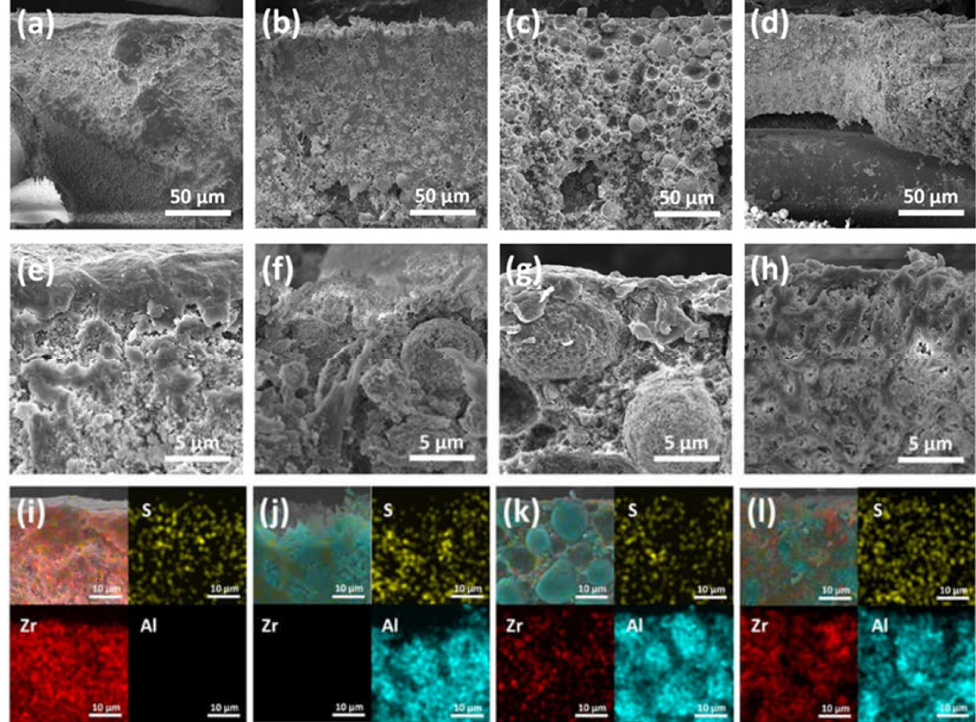
Figure 1. XRD patterns of commercial Zirfon ® and prepared separator membranes.